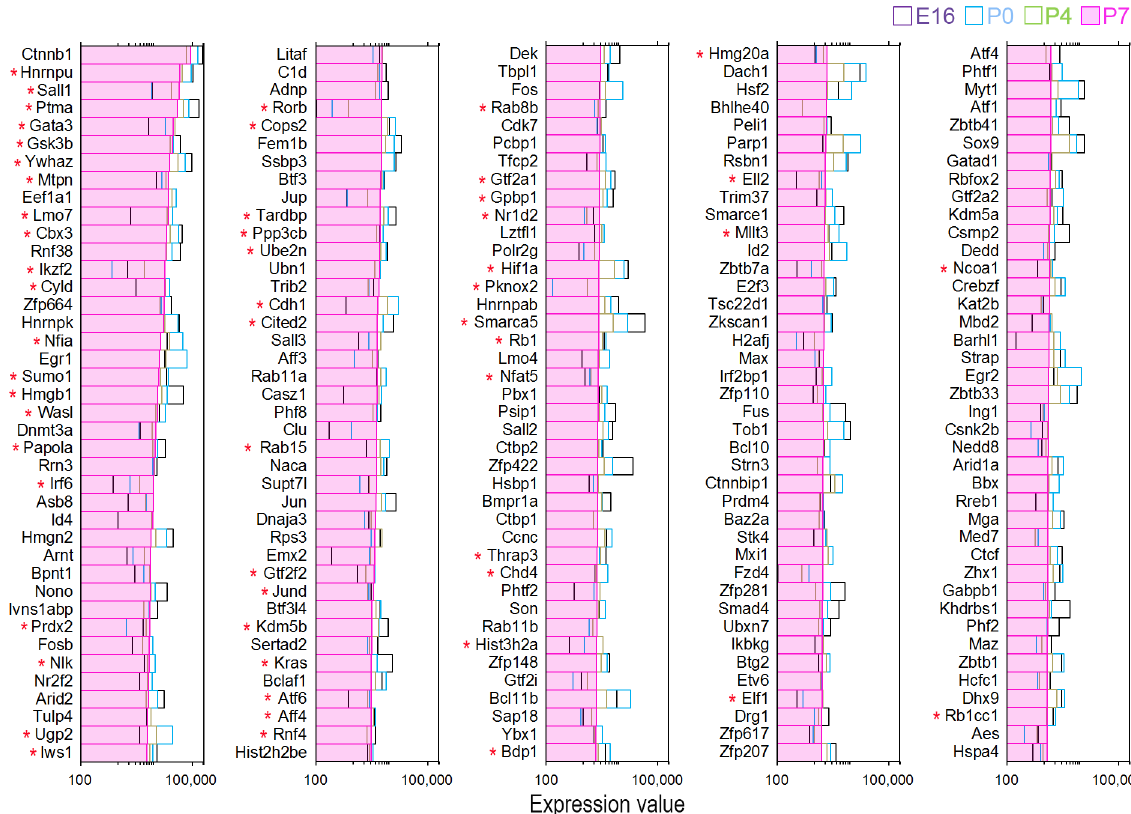
Fig 4. Expression levels of the top 200 TF genes expressed in P7 HCs. The expression of the same TF genes between E16 and P4 is also plotted for comparison. Gene expression profiles at different ages are color-coded. 55 TF genes that are expressed in both P7 and adult HCs are marked by red